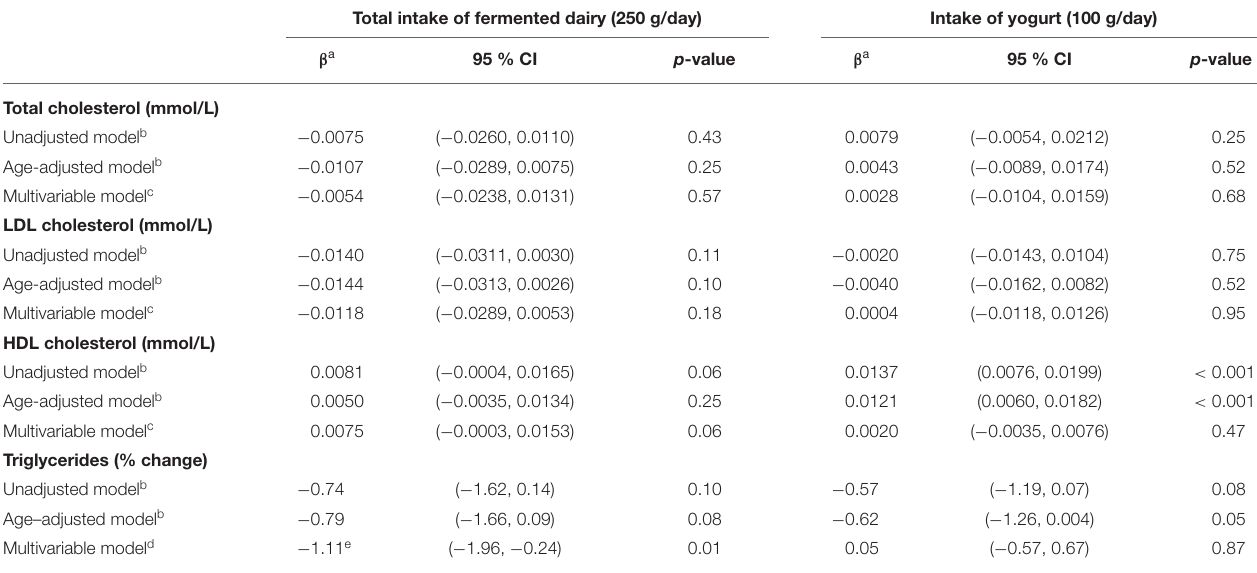
TABLE 2 | Linear regression coefficients for the associations between blood lipids and total intake of fermented dairy products and intake of yogurt. The Tromsø Study: